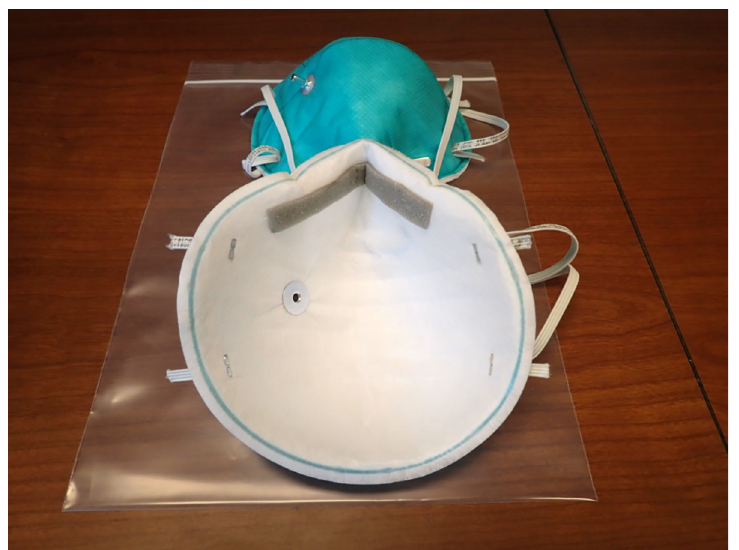
Fig 1. Model 1-N95 cup-shaped